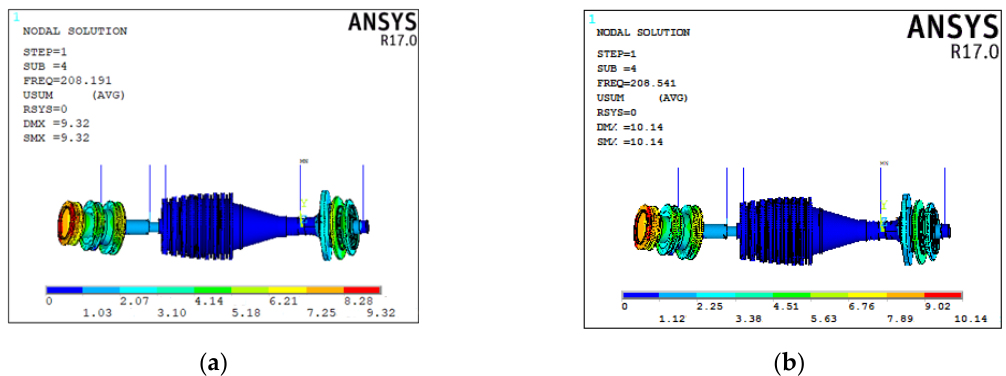
Figure 23. Comparison of the 3rd modal between parallel non-concentricity and the front deflection angle non-concentricity: ( a ) δ = 2 mm; ( b ) θ = 0.18°.